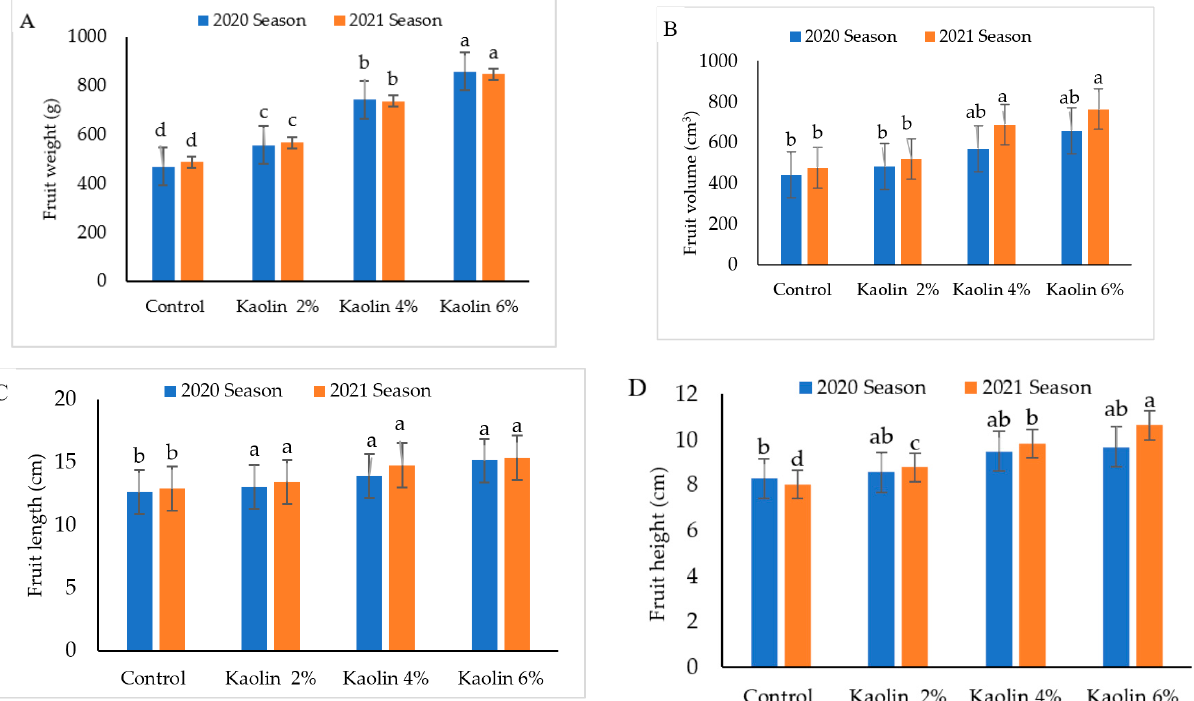
Figure 7. Effect of kaolin spray on: ( A ) fruit weight (g), ( B ) fruit volume (cm 3 ), ( C ) fruit length (cm) and ( D ) fruit height (cm) of Keitt mango cultivar during the seasons 2020 and 2021. Bars indicate mean values ± SE (n = 9). Different letters above columns indicate significant differences among pruning treatments at p = 0.05 according to Bartlett’s test.